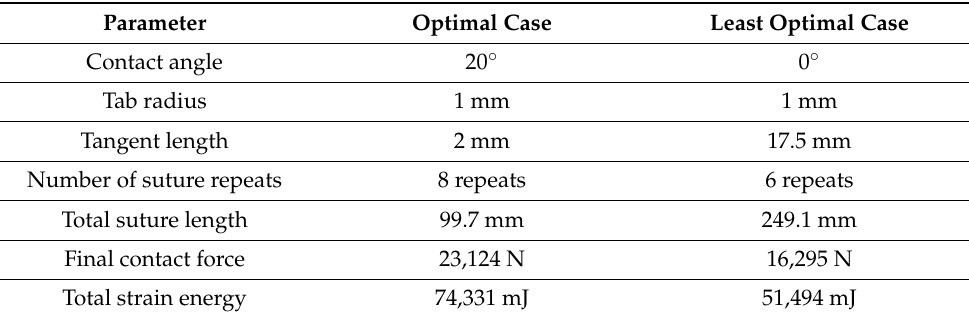
Figure 9. ( a ) Final contact force and ( b ) total strain energy plotted as a function of the total suture length in each archway pair. Table 2. Geometric parameters of best- and worst-performing cases.